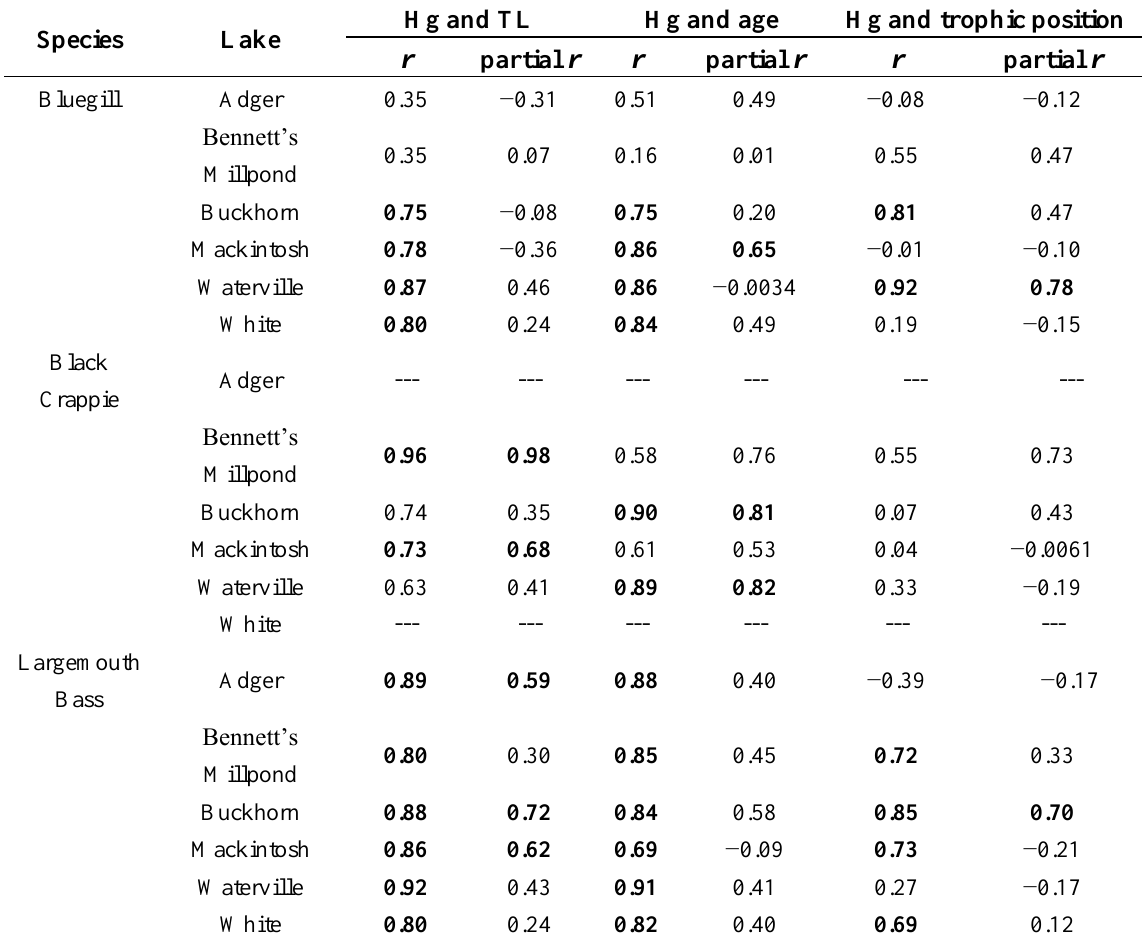
Table 2. Pair-wise and partial correlations of log fish tissue Hg (ppm) with fish total 10 length (mm TL), age (years) and trophic position (as measured by nitrogen isotopes) for bluegill, black crappie and largemouth bass collected in six lakes in North Carolina, USA. Partial correlations indicate correlations between fish tissue Hg and each factor individually while removing the effects of the other two factors. Bold text indicates significant relationships ( P < 0.05, adjusted with a Bonferroni correction to P < 0.008). Hg and TL Hg and age Hg and trophic position Species Lake r partial r r partial r r partial r Bluegill Adger 0.35